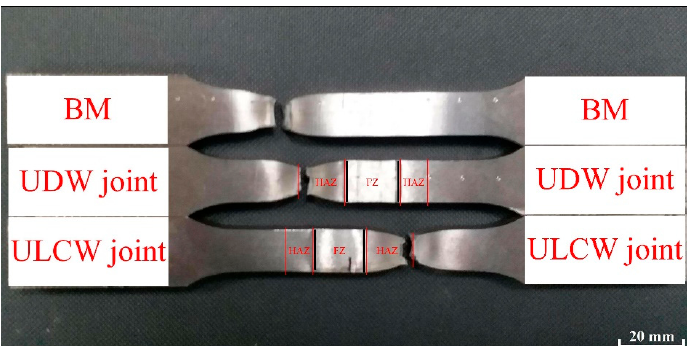
Figure 9. Fracture locations for the tensile test specimens.